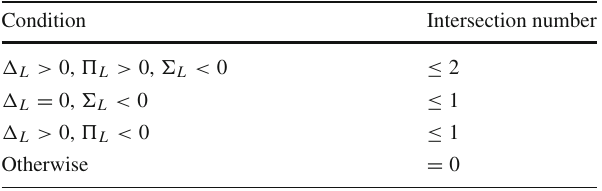
Table 8 The ‘Right’ intersection number n R φ ± when the action is PT -symmetric